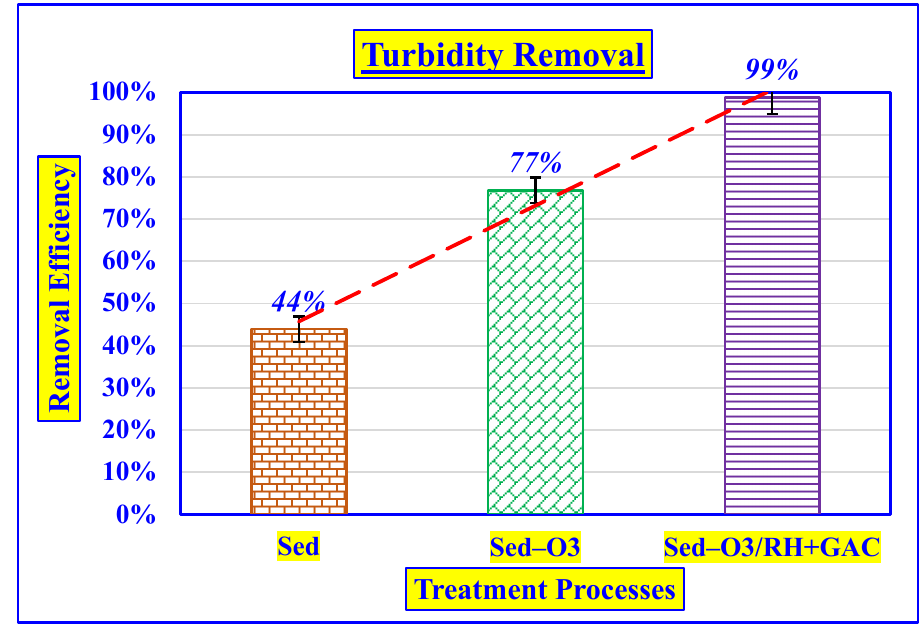
Figure 6. Turbidity removal by hybrid system (Initial turbidity = 669 ± 16 NTU; O 3 = 82.5 ± 2.2 mg/L; peristaltic pump speed = 150 rpm; C.T = 18 min; GAC = 200 g; RH = 200 g; pH = 6.9 ± 0.2; volume = 4 L; T = 25 ± 2 ◦ C).